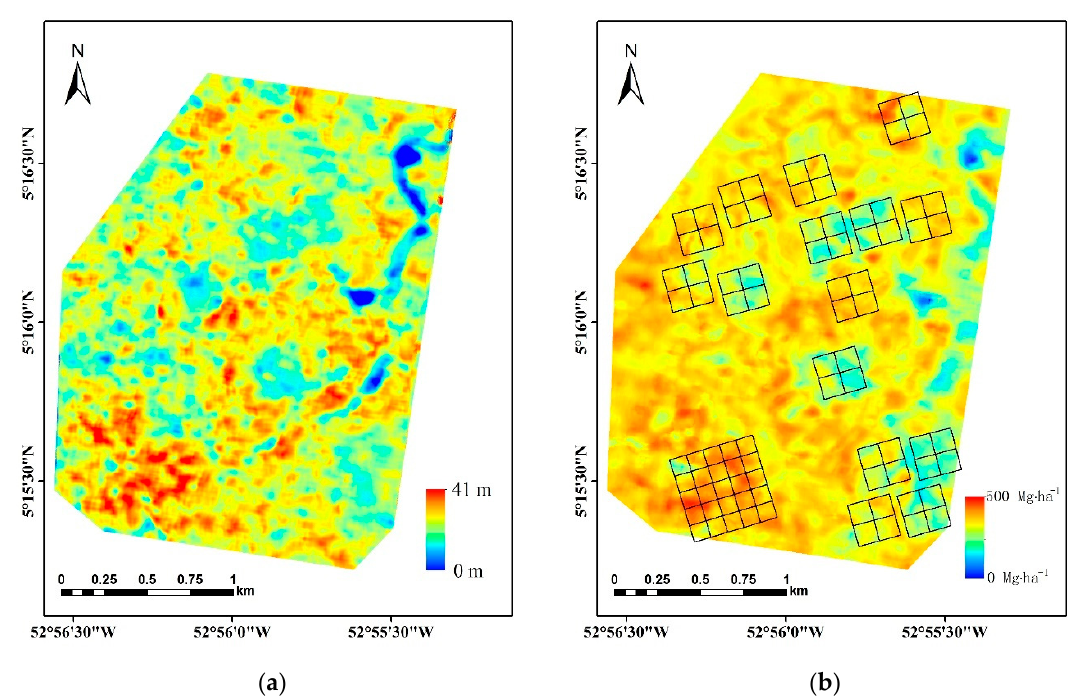
Figure 18. LiDAR-derived Canopy Height Model (CHM) ( a ) and the forest above-ground biomass (AGB) estimation from TomoSAR dataset ( b ).